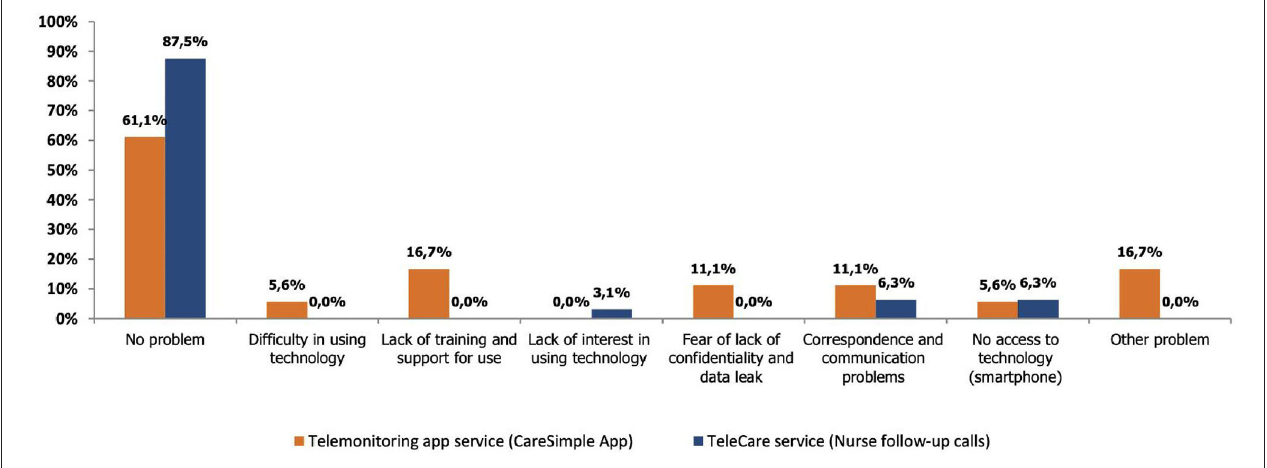
FIGURE 4 | Types of problems encountered using the platform.